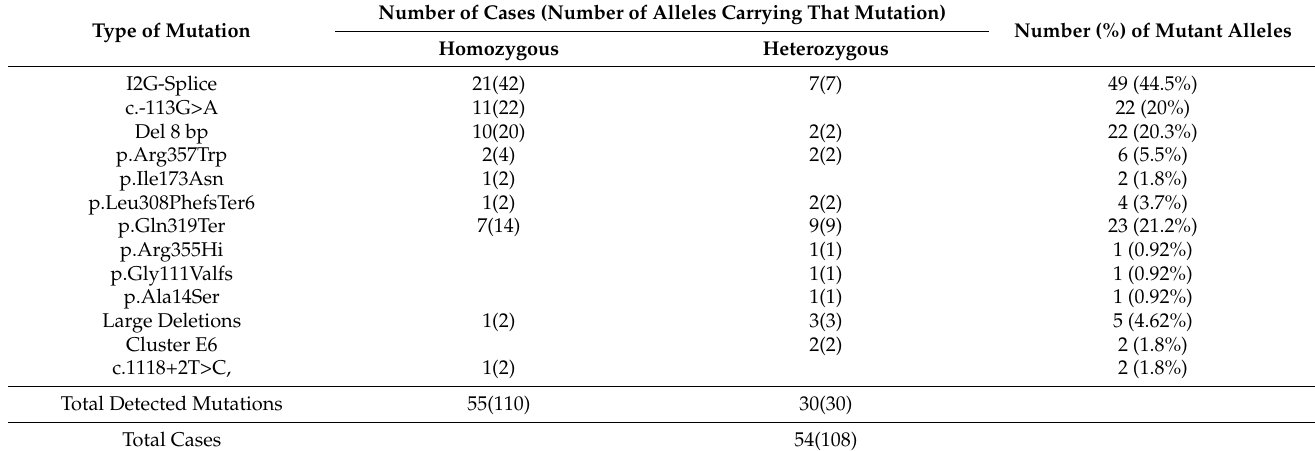
Table 1. Frequency distribution of different CYP21A2